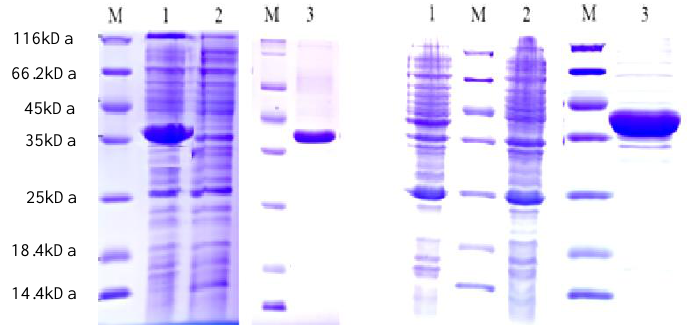
Figure 5. SDS-PAGE analysis of purified recombinant proteins from E. coli. M: molecular mass standards.